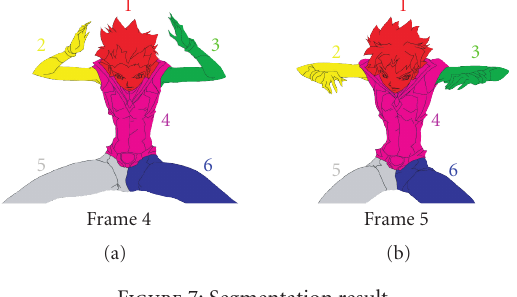
Figure 7: Segmentation result.